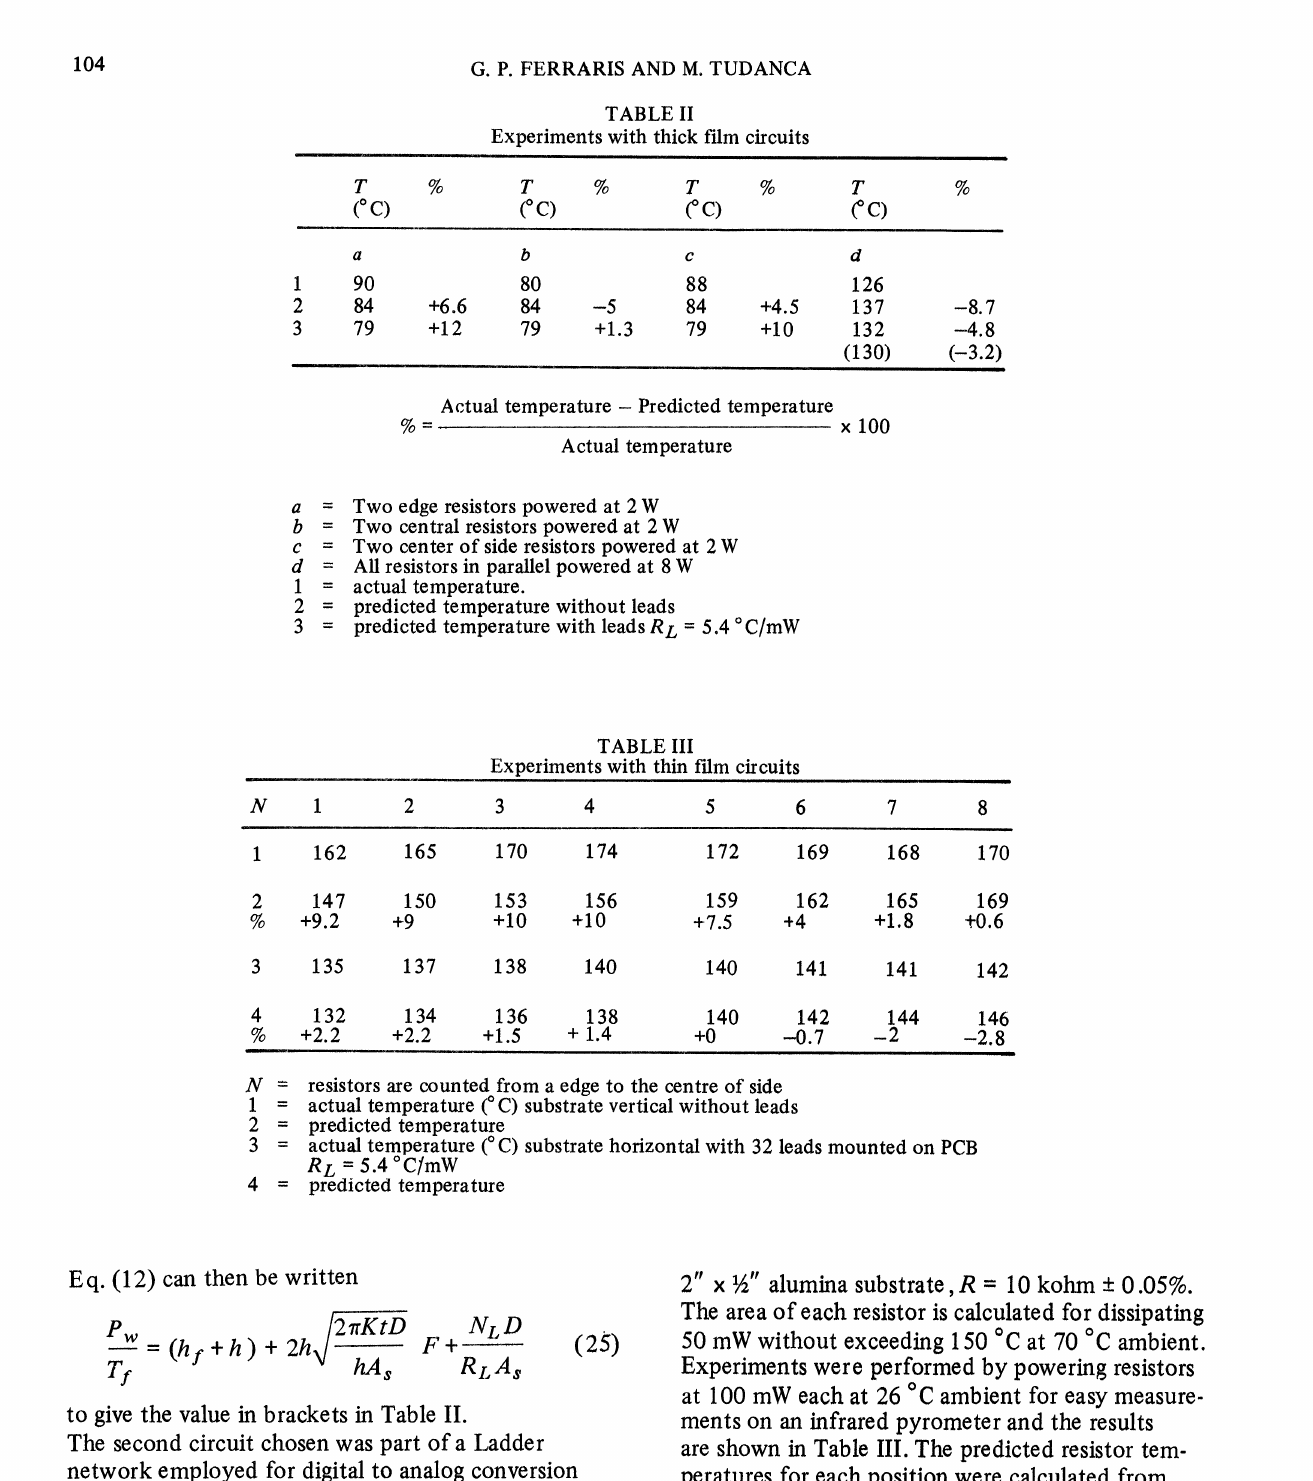
TABLE III Experiments with thin film